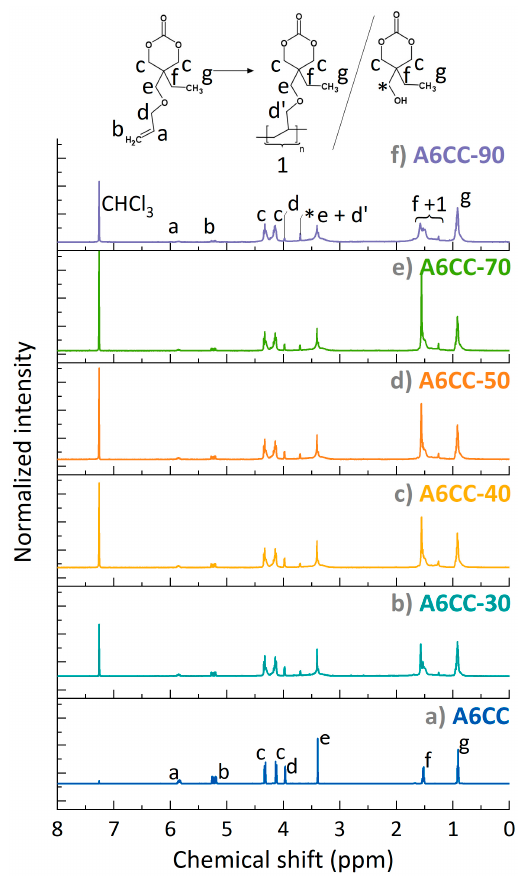
Figure 3. 1 H NMR spectra (in CDCl3) normalized according to the methylene group (signal g) of monomer ( a ) A6CC before and after the plasma-induced polymerization. ( b ) A6CC-30, ( c ) A6CC-40, ( d ) A6CC-50, ( e ) A6CC-70 and ( f ) A6CC-90. * assigned to the chemical structure shown in the figure.